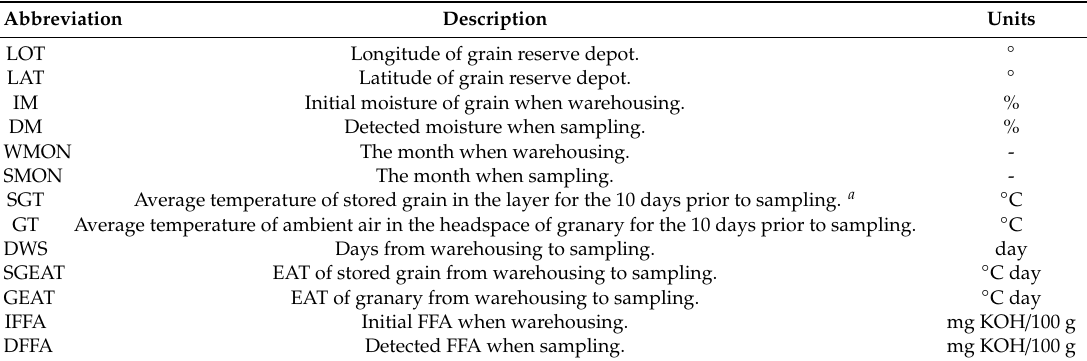
Table 2. Storage factors